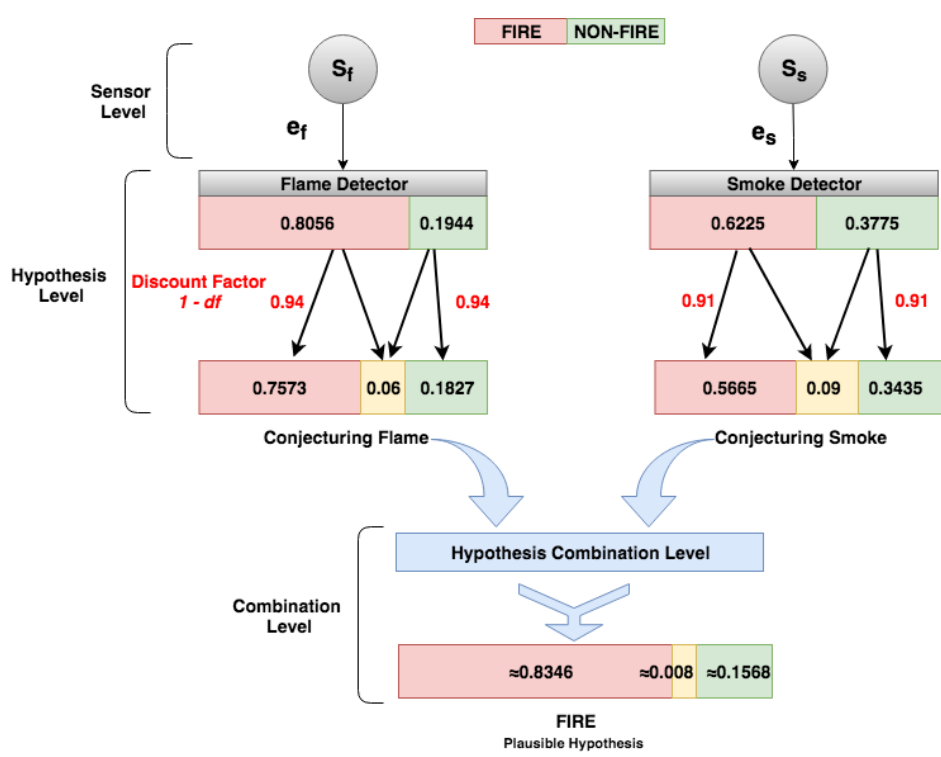
Figure 9. DST-CEP computing processing levels of the fire detection